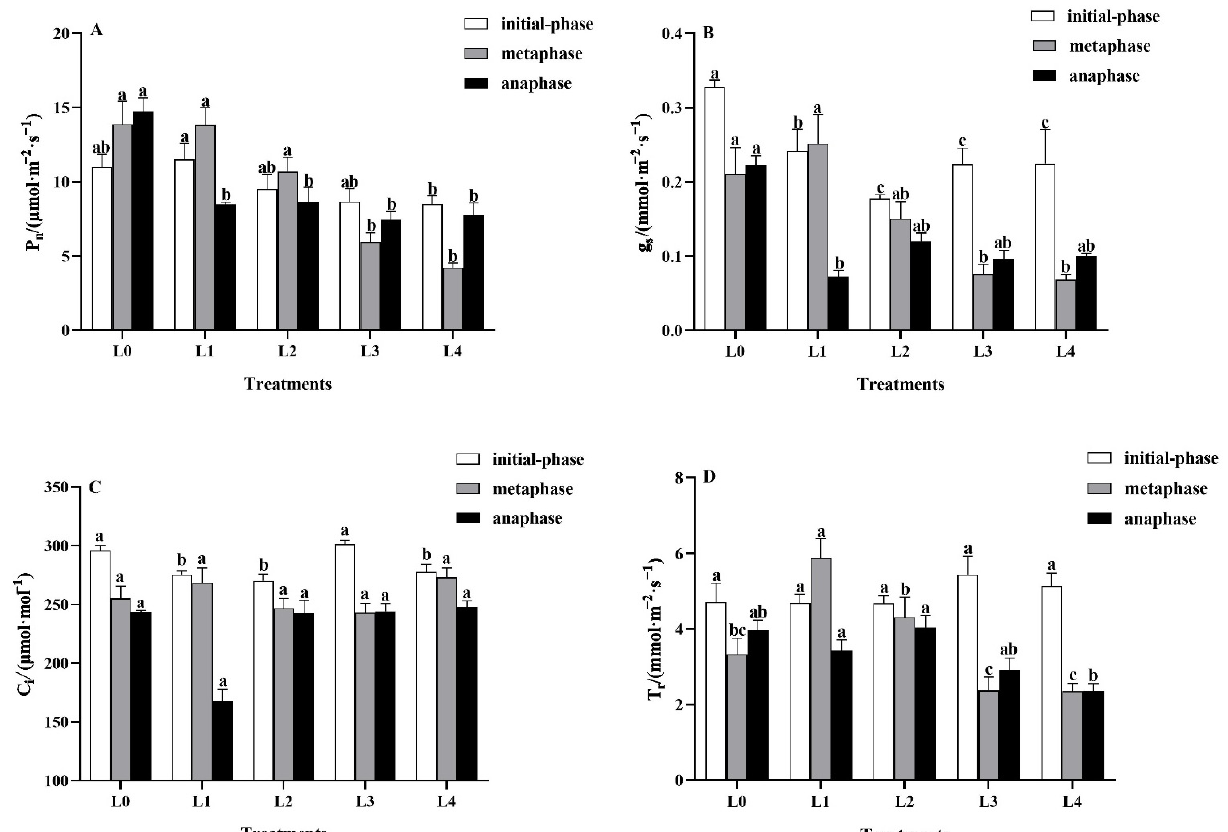
Figure 3. Effects of different light intensities on leaf gas exchange indicators for ( A ) net photosynthetic rate (P n ), ( B ) stomatal conductance (g s ), ( C ), intercellular CO 2 concentration (C i ), and ( D ) transpiration rate (T r ) of Ma bamboo. Note: L0, L1, L2, L3, and L4 refer to 100%, 40%, 30%, 20%, and 10% of natural light, respectively. Values are the means ± SE of four replicates per treatment. Different letters indicate significant differences between treatments at the same shooting period ( p < 0.05).